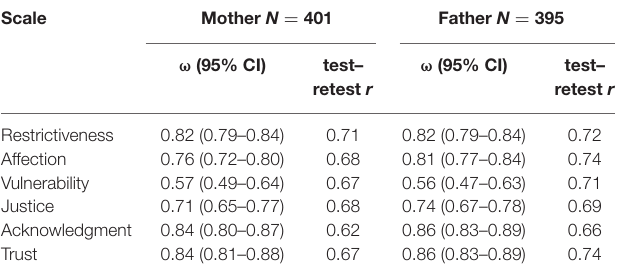
TABLE 1 | Model-based scale score reliabilities with Mcdonald’s omega ( Ω ) with bootstrapped 95% confidence intervals of the CFRT and test–retest